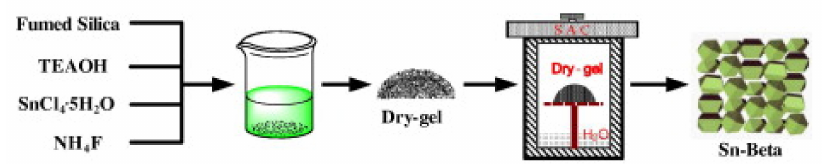
Figure 2. Illustration of the Sn-Beta zeolite preparation by SAC method. Reproduced with permission from [29]. Copyright 2012,